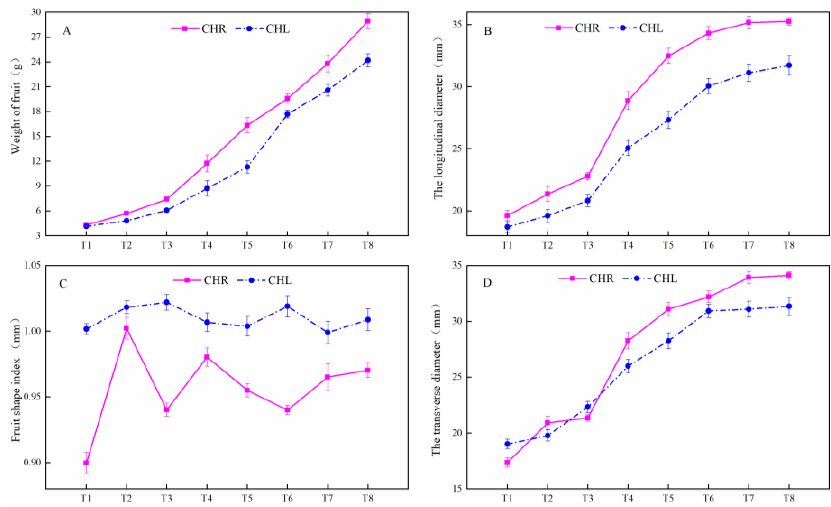
Figure 1. Fruit weights ( A ), longitudinal diameter ( B ), fruit shape ( C ), and transverse diameter ( D ) changes during CHL and CHR plum ripening. Sampling stages T1, T2, T3, T4, T5, T6, T7, and T8 represent 60, 70, 80, 90, 100, 105, 110, and 115 days after flowering, respectively, the same as below. Each value is the mean for three replicates. The vertical bar indicates the standard error.